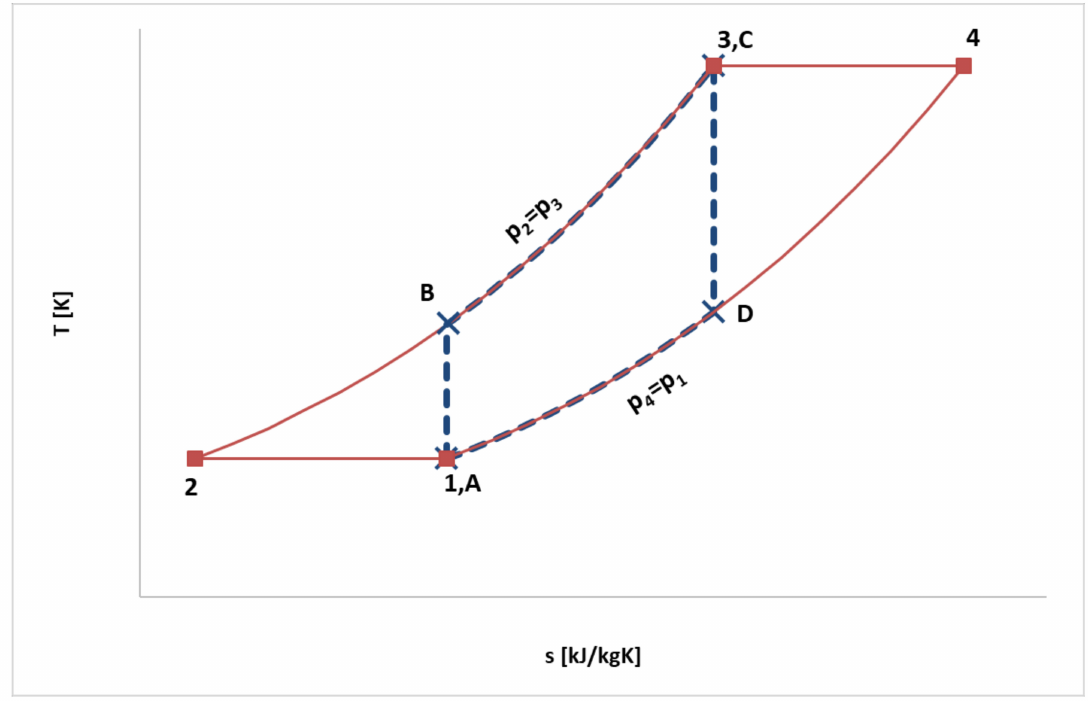
Figure 2. Comparison of Brayton cycle (dotted blue line) and Ericsson cycle (red line) (interpretations in T-s